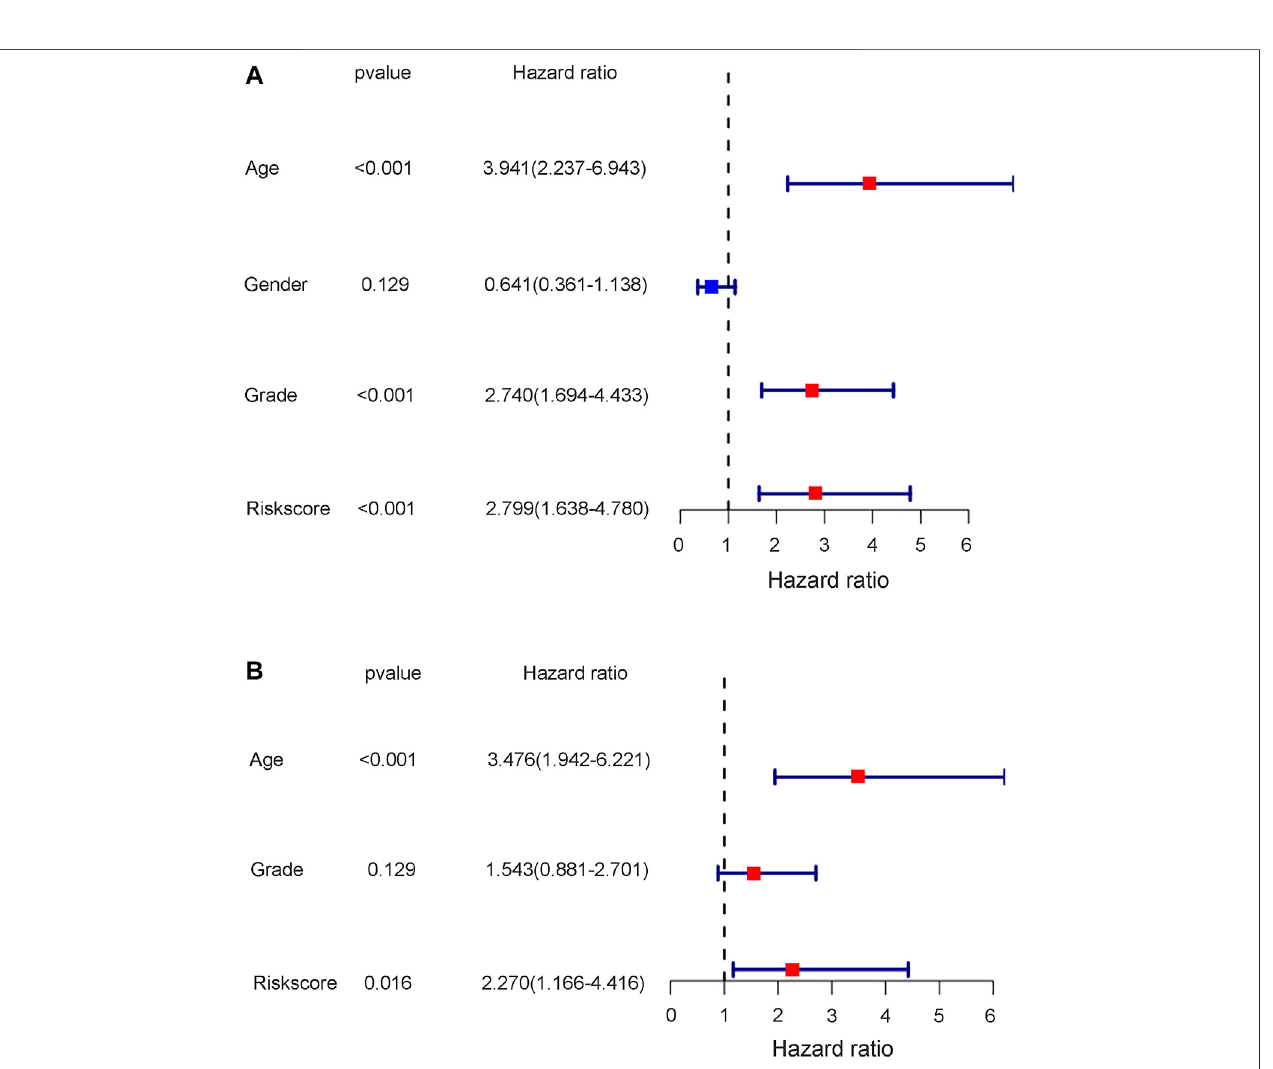
Frontiers in Molecular Biosciences |